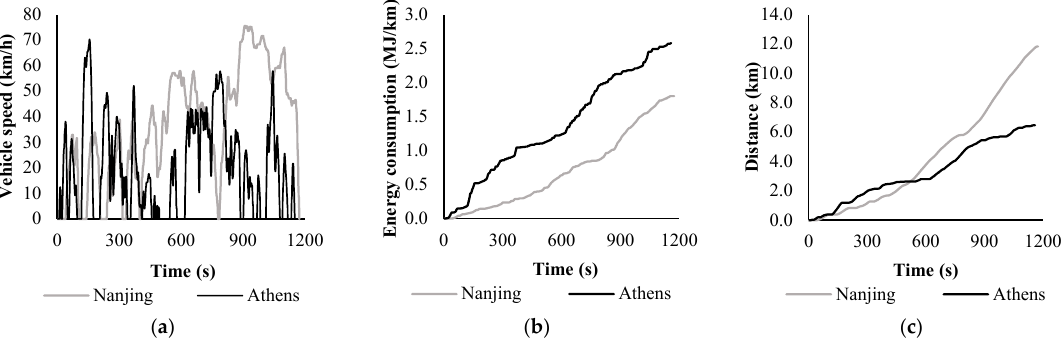
Figure 5. For Athens LDC and Nanjing LDC: ( a ) vehicle speed, ( b ) energy consumption, and ( c ) distance, in function of time.